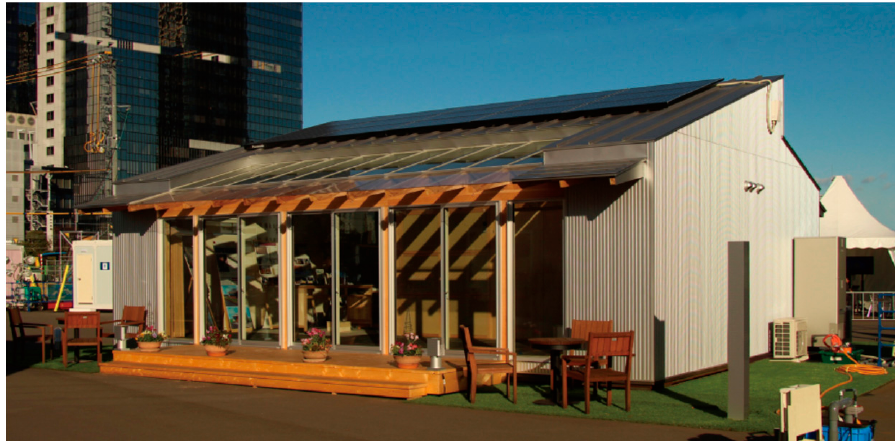
Figure 2. South façade of proposed ZEH.